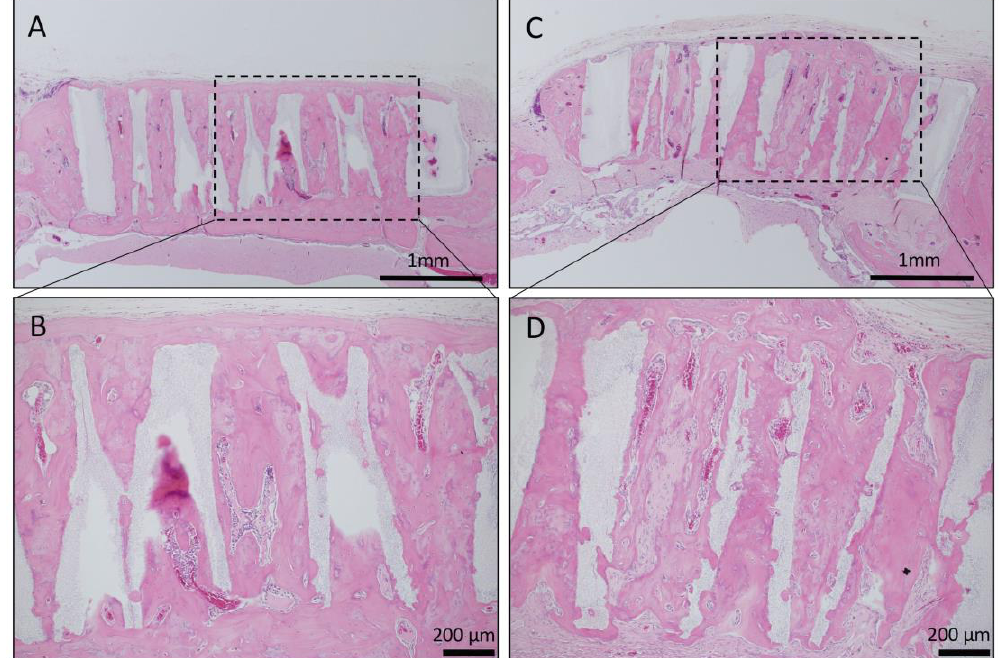
Figure 7. Histological images of β-TCP with Collagen gel + BMP-2 or Collagen gel alone at 6 months after implantation. ( A ) Low-magnification image of vertical β-TCP with collagen alone. Continuity with surrounding existing bone and new bone around β-TCP was observed. ( B ) Higher-magnification image of corresponding outlined area in (A). Vigorous bone formation was observed in the holes of β-TCP; however, the absorption of β-TCP was not observed. ( C ) Low-magnification image of vertical β-TCP with Collagen gel + BMP-2. Continuity with surrounding existing bone and new bone around β-TCP was observed. ( D ) Higher-magnification image of corresponding outlined area in (C). Vigorous bone formation was observed in the holes of β-TCP, and the absorption of β-TCP was also observed.